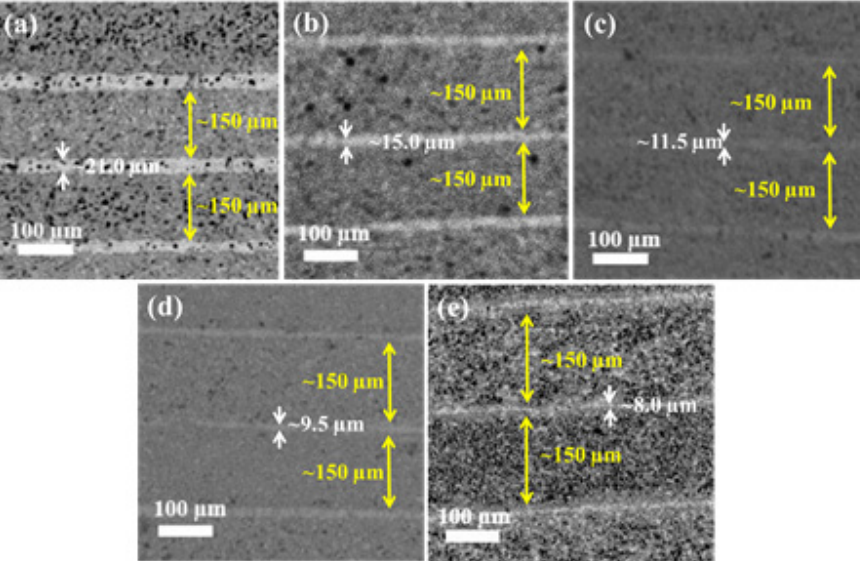
Figure 5. SEM images of the laminated ceramics with different layer thickness ratios: ( a ) λ = 7, ( b ) λ = 10, ( c ) λ = 13, ( d ) λ = 16, ( e ) λ = 19